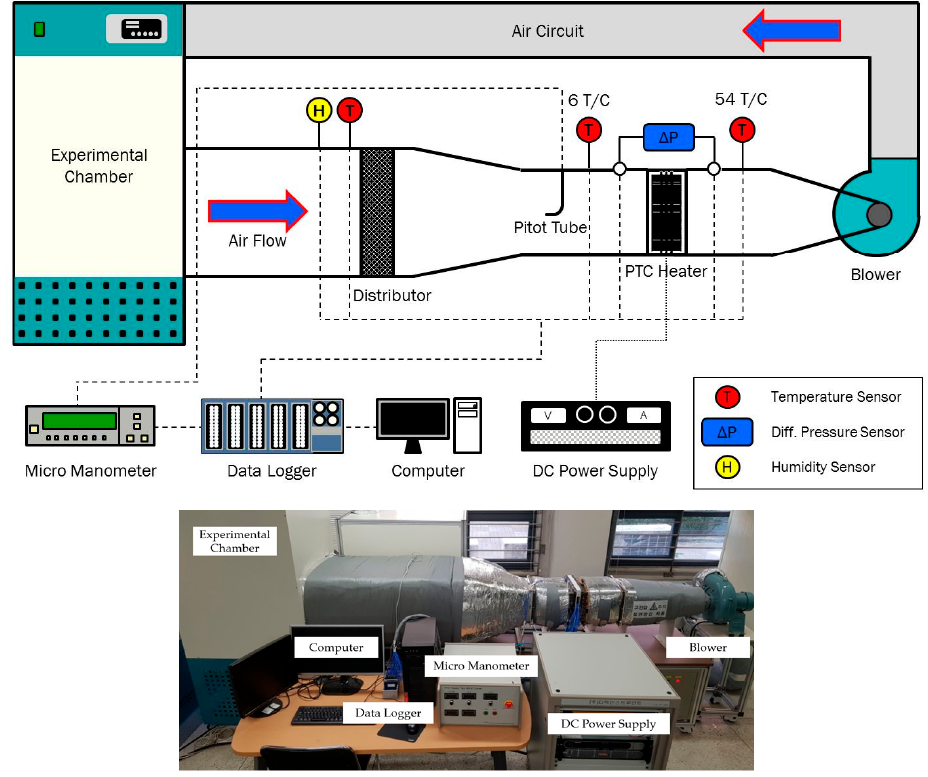
Figure 2. Schematic diagram and photo of the PTC heater experimental apparatus.